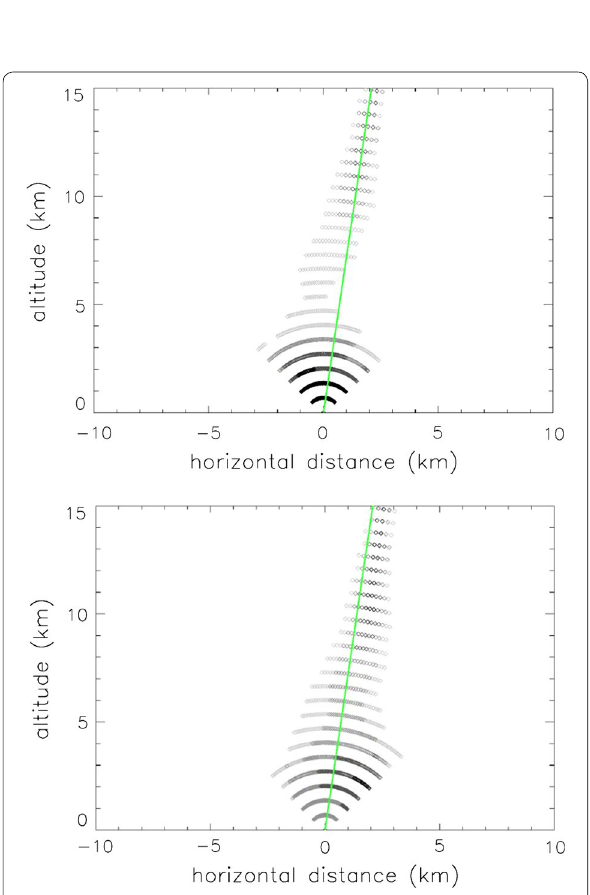
Fig. 8 Cross sections of the ray-tracing results with an azimuth angle of 60°, assuming the background wind velocity profiles shown in Fig. 7, for the acoustic source located in the center of the EAR antenna (top panel) and the speakers located 50 m away from the antenna center toward east (bottom